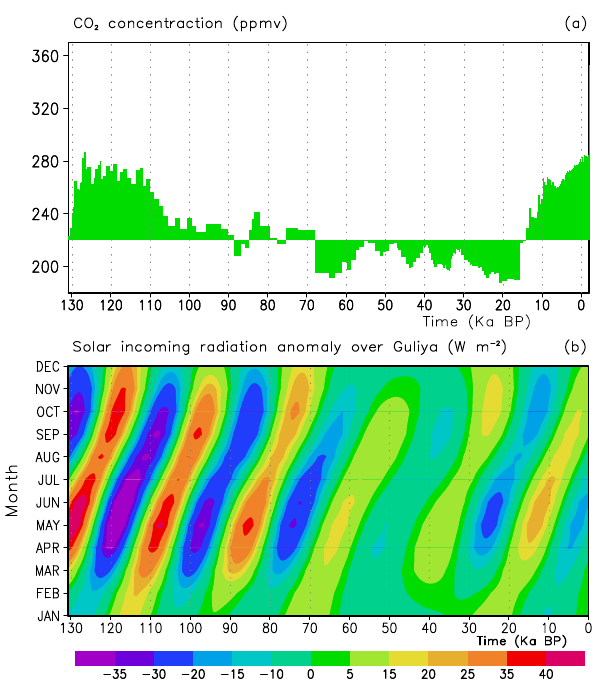
Fig. 1 . (a) CO 2 concentration and (b) annual cycles of incoming solar radiation Fig. 1. (a) CO 2 concentration and (b) annual cycles of incoming anomaly relative to the climatological mean over the past 130 ka. The abscissa is solar radiation anomaly relative to the climatological mean over the past 130ka. The abscissa is time before the present, and the ordinate time before the present, and the ordinate in (b) is the month of a year. in (b) is the month of a